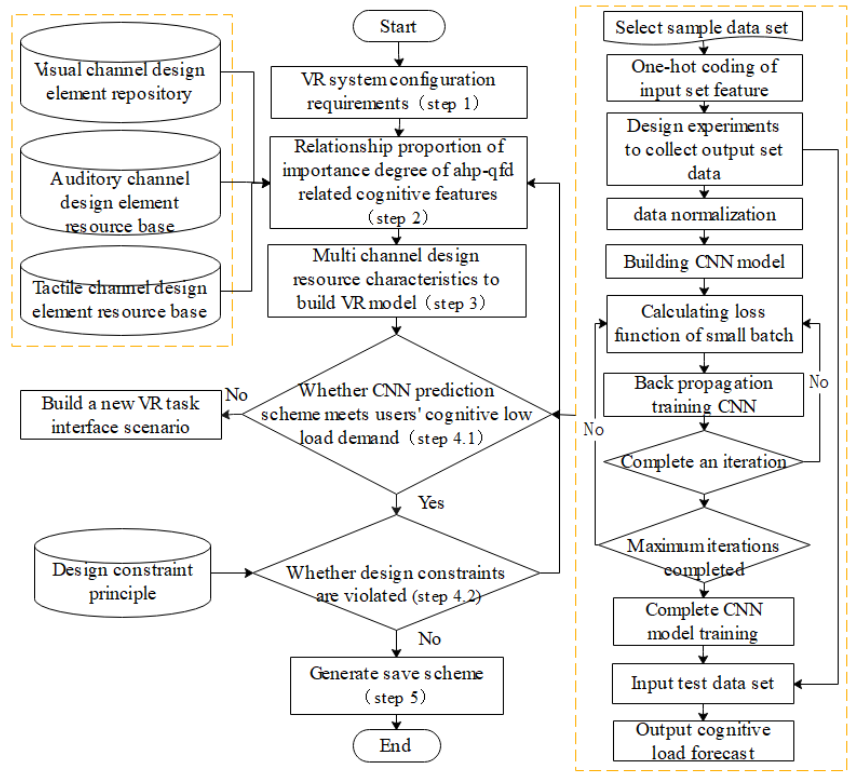
Figure 5. Prediction model task flow.